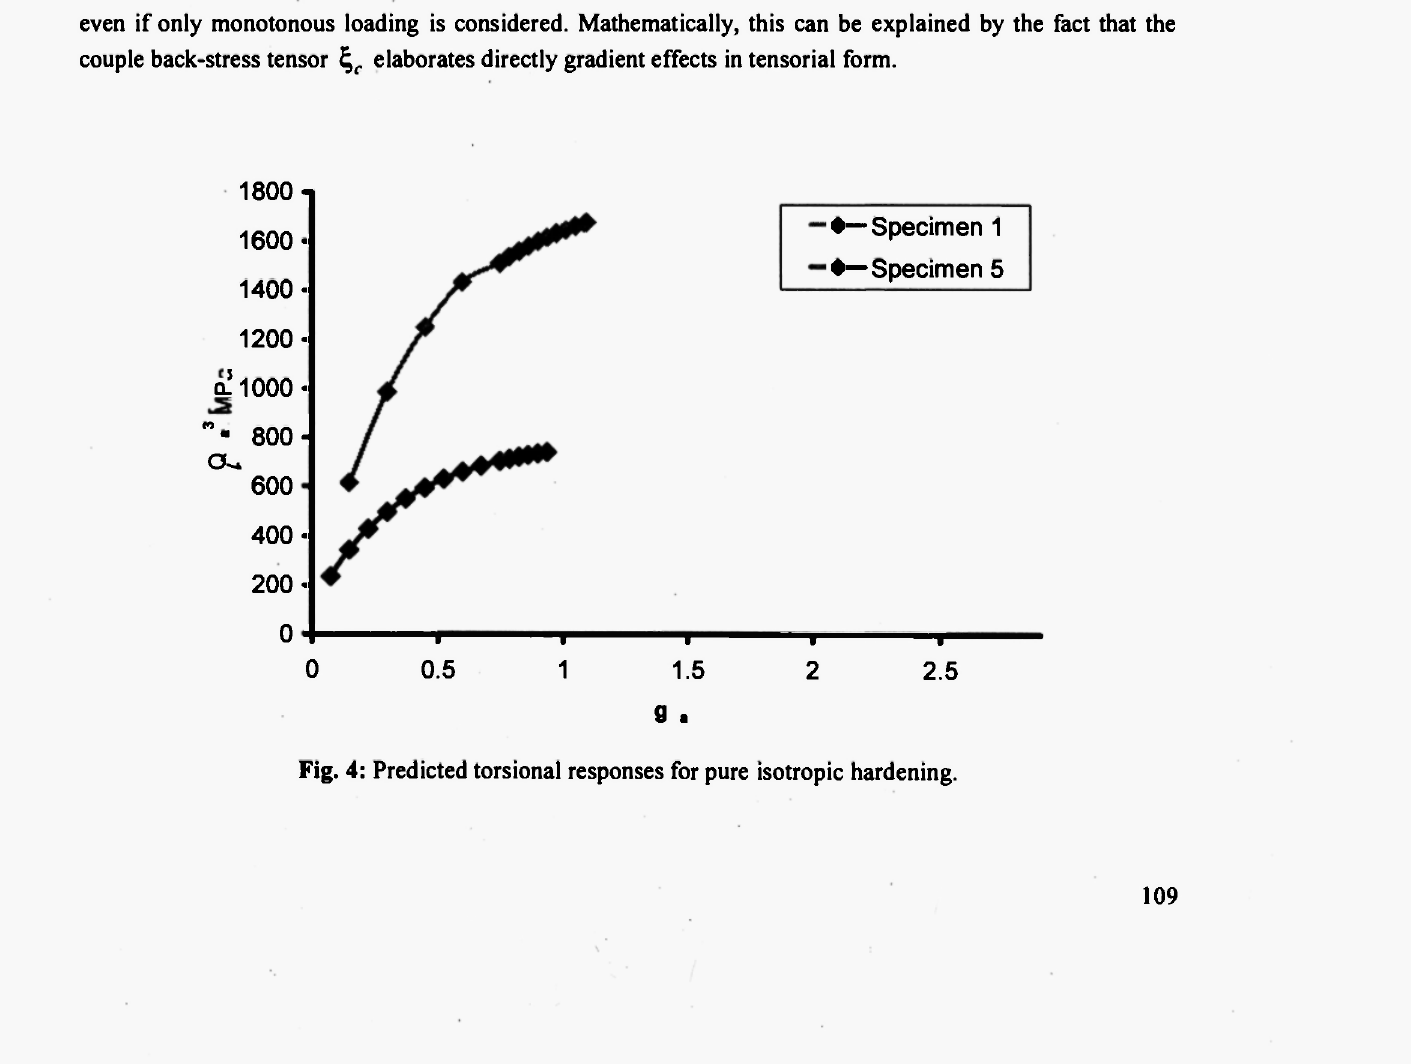
Fig. 4: Predicted torsional responses for pure isotropic